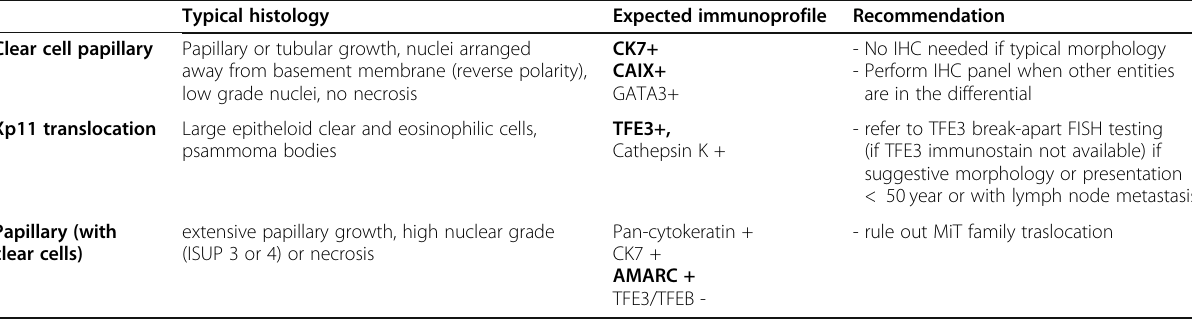
Table 2 Papillary tumors with predominant clear cells Typical histology Expected immunoprofile Recommendation